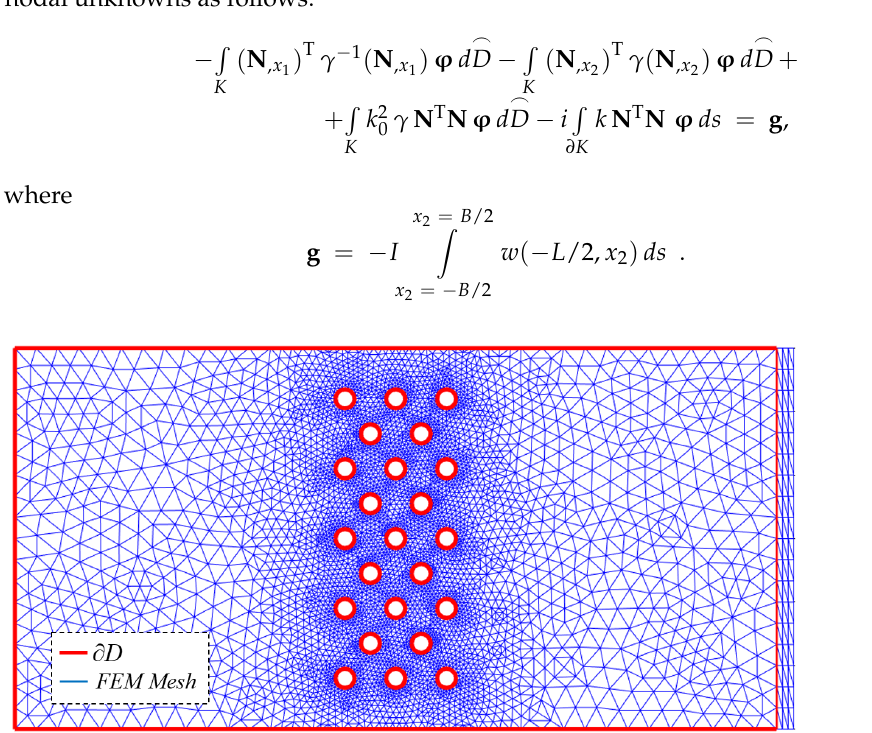
Figure 10. Indicative plot of Delaunay triangulation-based mesh of D , augmented by a regular triangular mesh in the PML region.